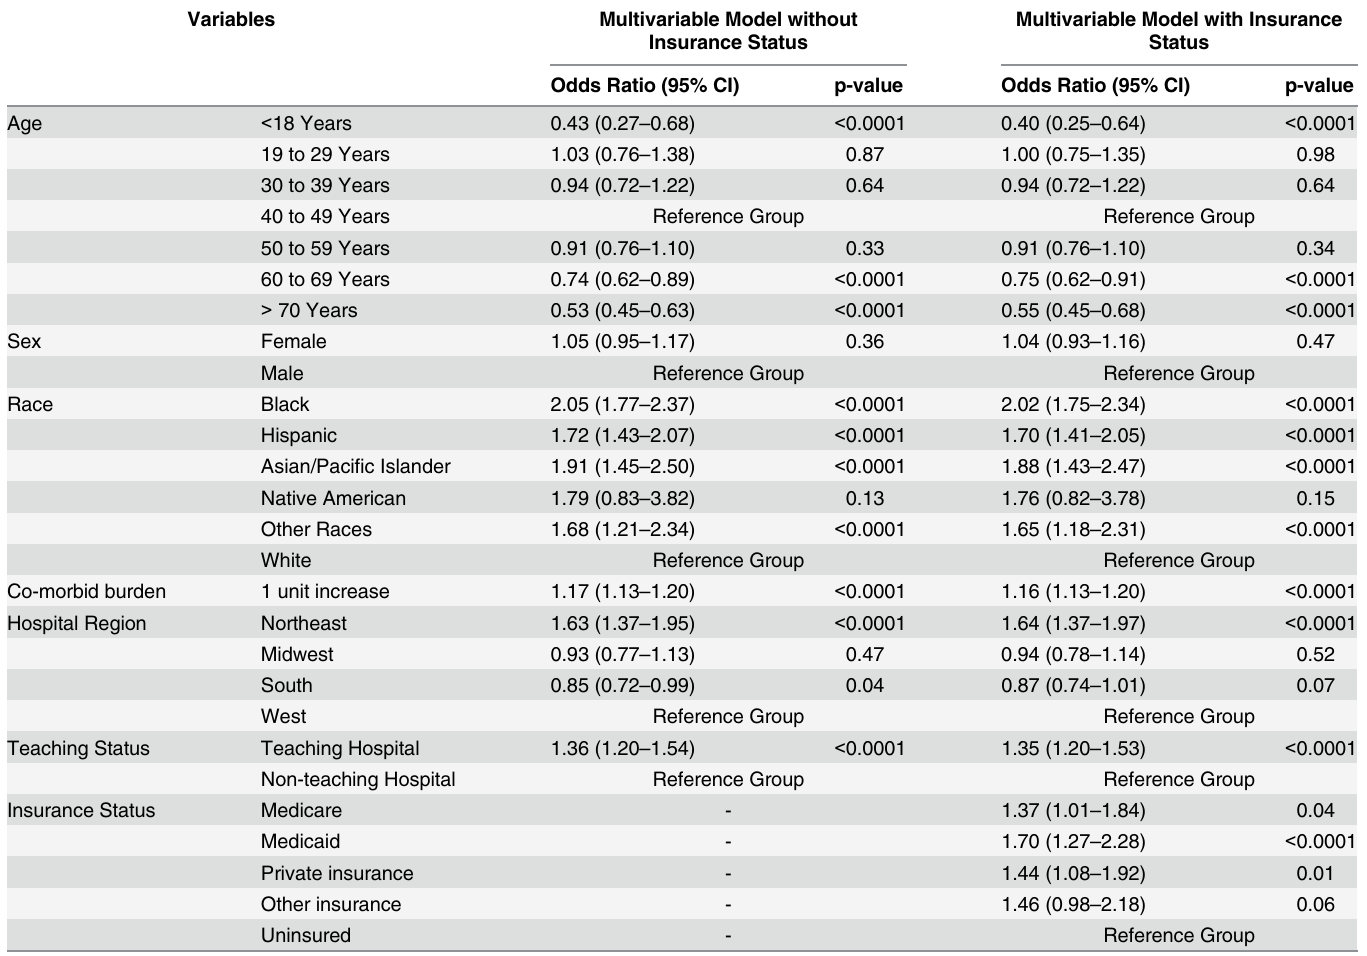
Table 3. Multivariable Logistic Regression for Performance of